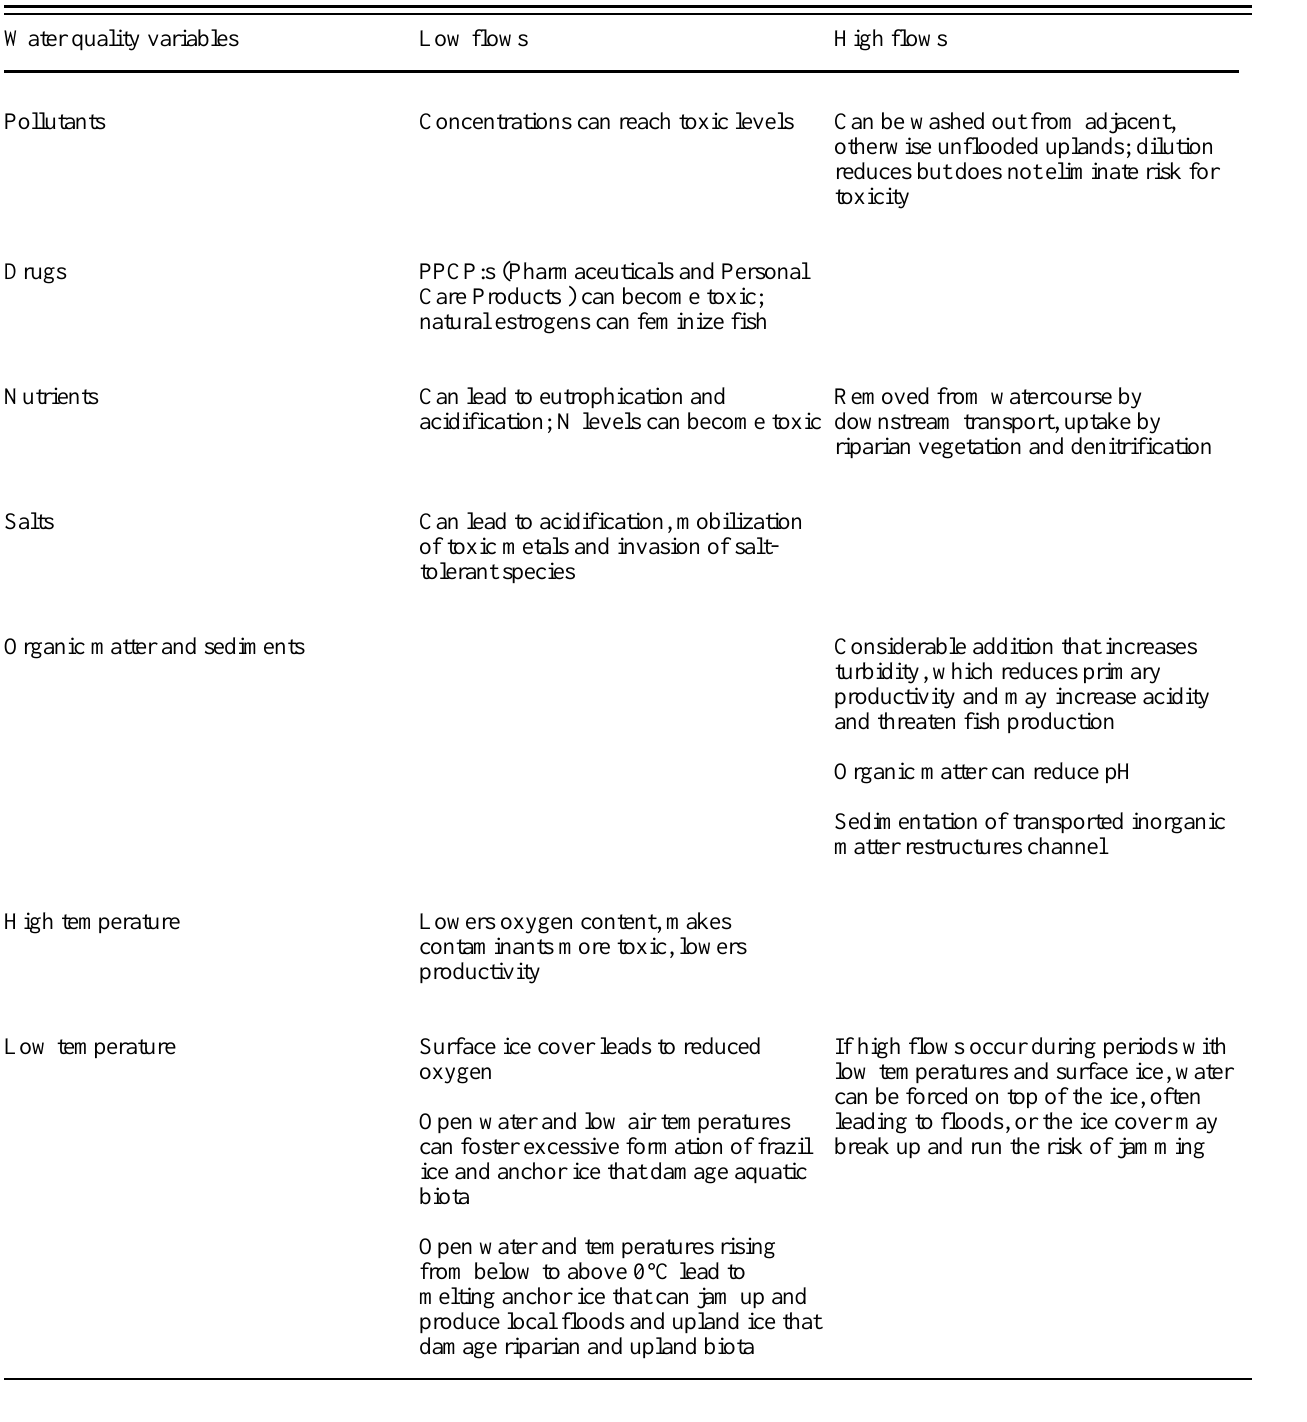
Table 1. Examples of situations when combinations of water quality variables and extreme discharge conditions can produce environmental